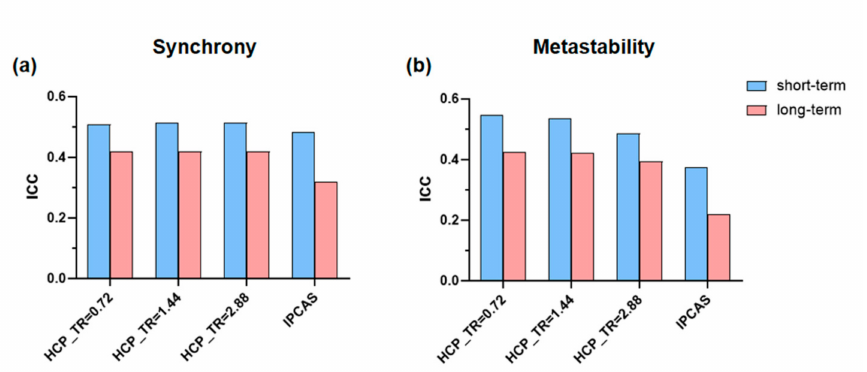
Figure 4. Reliabilities of synchrony ( a ) and metastability ( b ) in different spatial resolutions, evaluated by the intraclass correlation coefficient (ICC). Blue bars represent short-term reliability and pink bars represent long-term reliability.